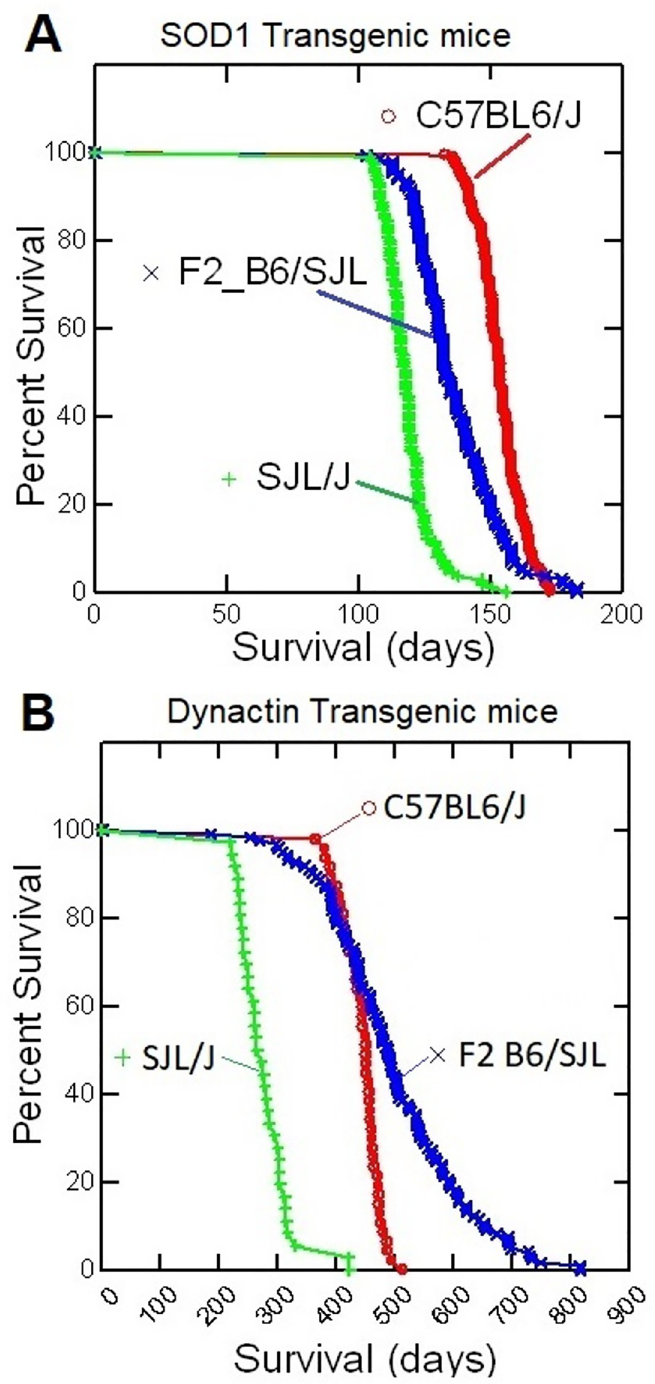
Fig 1. Survival curves for SOD1 and dynactin-1 transgenic mice. Survival curves for transgenic C57BL6/J, SJL/J mice and their F2 cross with [A] the G93A human SOD1 transgene or [B] the G59S human dynactin-1 transgene.